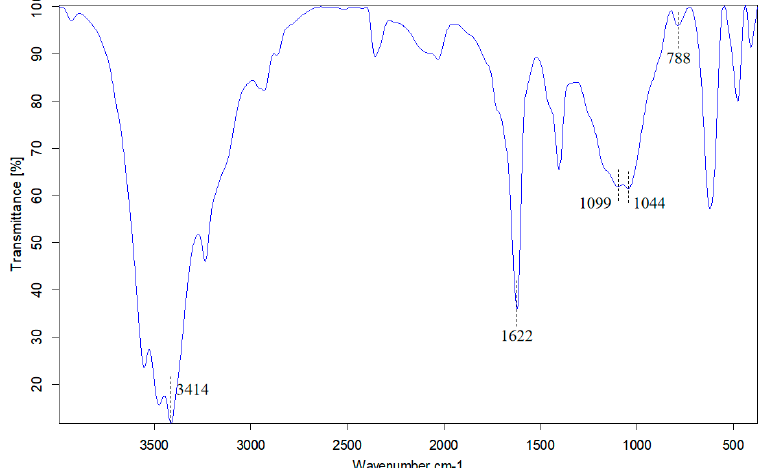
Figure 4. The infrared spectrum of film-coated XN-T.